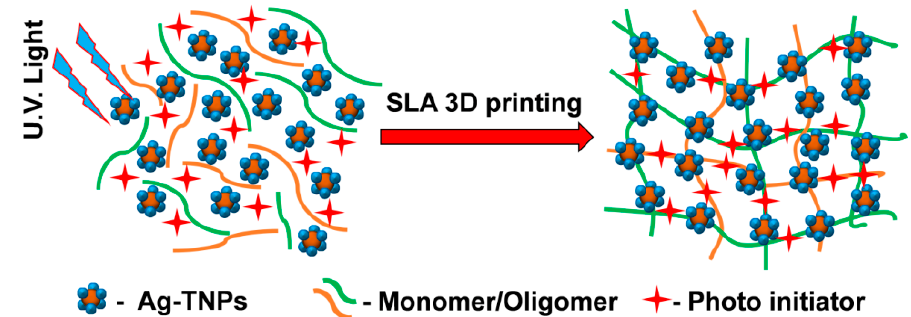
Figure 1. The schematic illustration of the induced photopolymerization of SLR (stereolithography resin) with the incorporated semiconducting Ag-TNP (Ag decorated TiO 2 nanoparticles) hybrids under UV light for SLA (stereolithography) 3D printing.